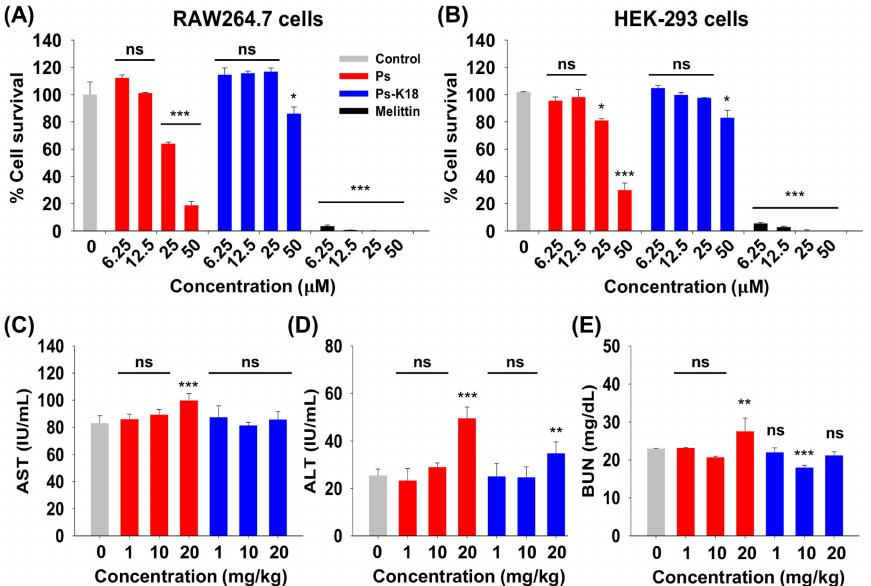
Figure 3. Cytotoxicity of Ps and Ps-K18 in vitro and in vivo. Concentration-dependent toxicities of pseudin-2 (Ps) and Ps-K18 against ( A ) RAW264.7 cells and ( B ) HEK-293 cells. ( C ) Aminotransferase (AST); ( D ) alanine aminotransferase (ALT); and ( E ) blood urea nitrogen (BUN) levels in mouse serum. The error bars represent means ± standard error of the mean. (* p < 0.05; ** p < 0.01; *** p < 0.001; ns. represents no